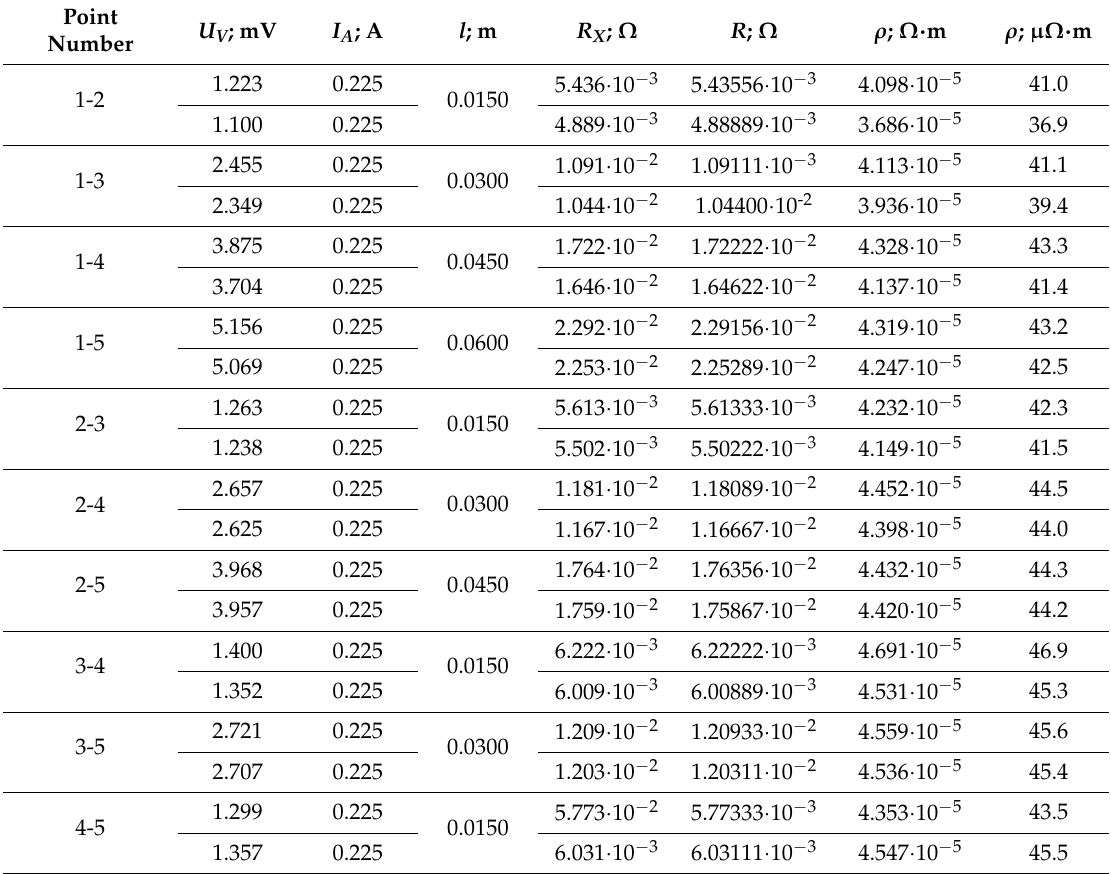
Table 3. Results of the recordings and calculations of GS material